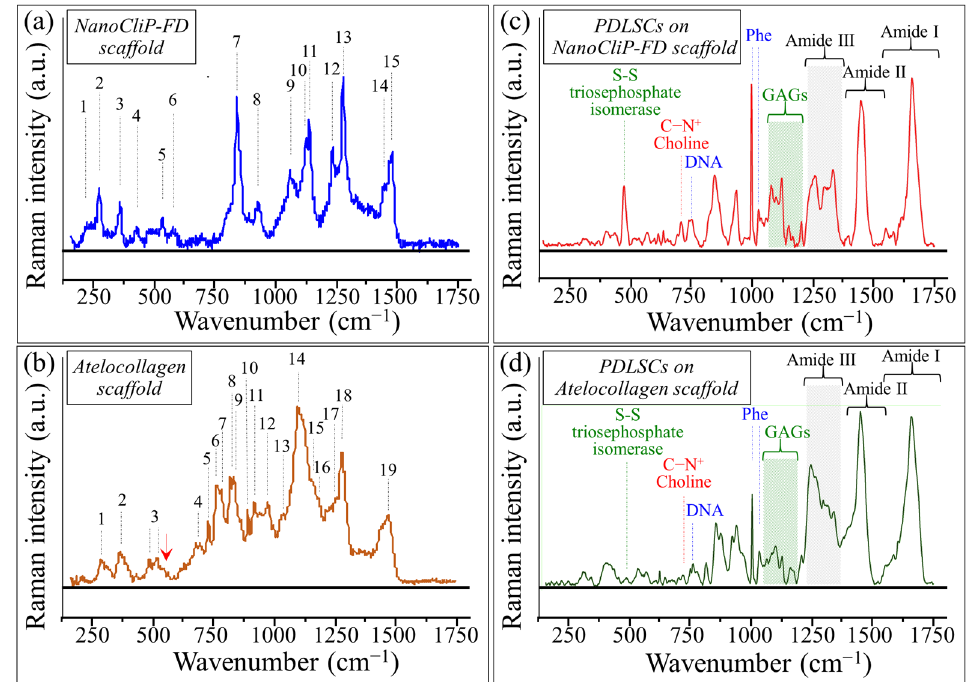
Figure 4. Average Raman spectra collected on ( a ) NanoCliP-FD gel and ( b ) atelocollagen scaffolds before exposure to PDLSCs; the labels of the main spectroscopic bands correspond to those listed in Tables 1 and 2, respectively. The red arrow in ( b ) represents a characteristic signal from α -helical polypeptide poly ( γ -benzyl glutamate). In ( c , d ), Raman spectra are shown of cartilage tissue grown by PDLSCs on NanoCliP-FD gel and atelocollagen scaffolds, respectively. Both spectra are normalized to the amide I band intensity (labels are explained in the text). Table 1. Wavenumbers and vibrational assignments of the main Raman bands found in the spec- trum of the NanoCliP-FD gel scaffold (band labels correspond to those shown in Figure 4a. Band Label